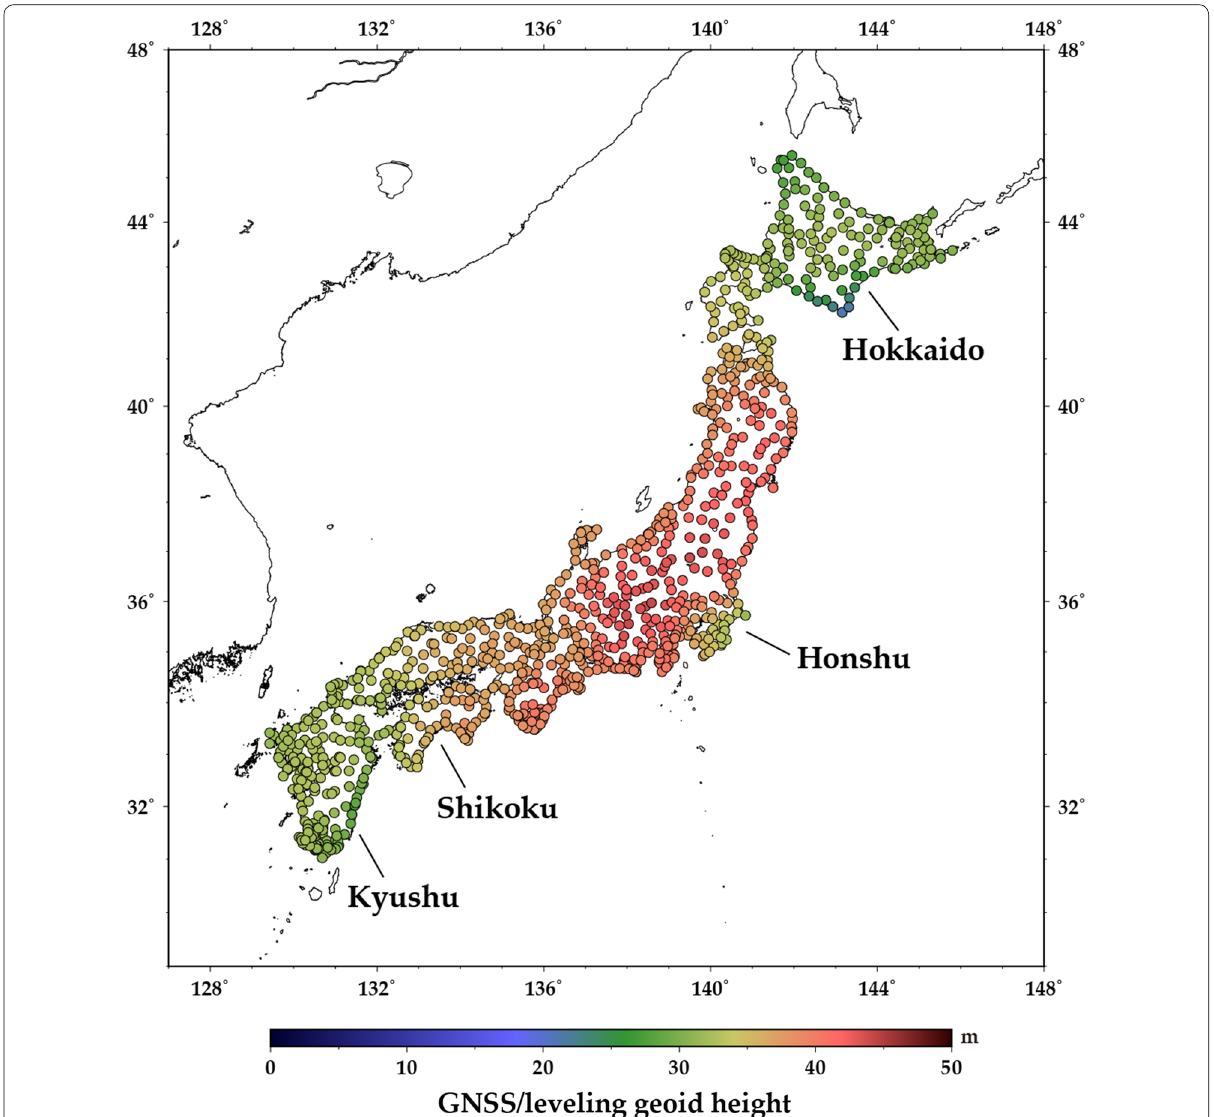
Fig. 1 Geographical map of GNSS/leveling geoid heights at 971 benchmarks. The total tide effect is eliminated (tide-free system) following Kuroishi et al.